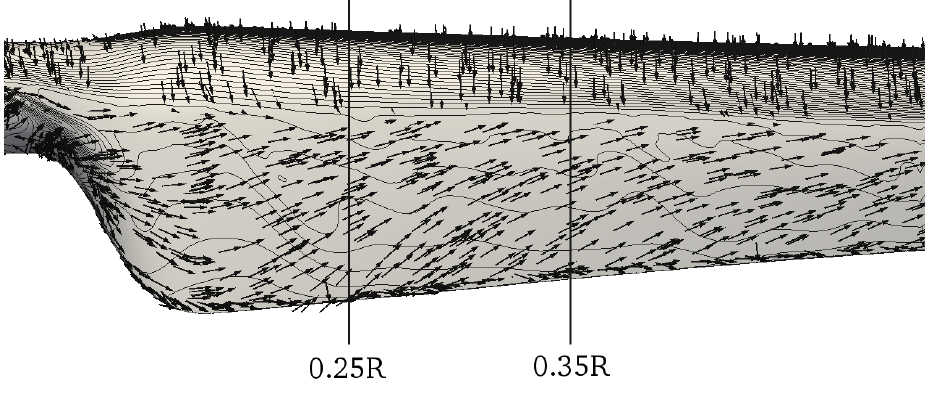
Figure 11. Computed isobars of surface pressure and arrows indicating the flow direction at U 1 = 24 m/s. The isobars go from 0 to 8000 Pa with an interval of 80 Pa. The radial flow in the separated region is mostly unrelated to the pressure